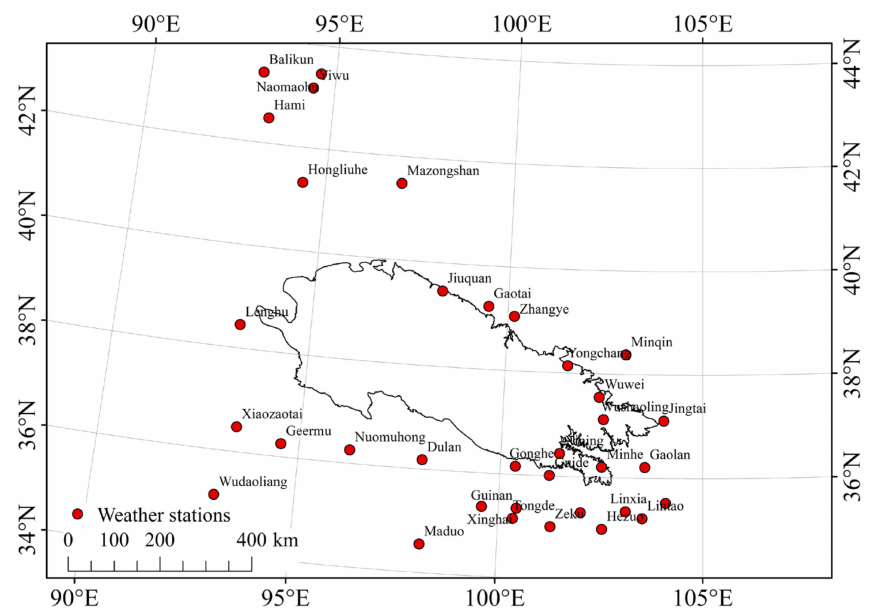
Figure 3. Distribution of weather